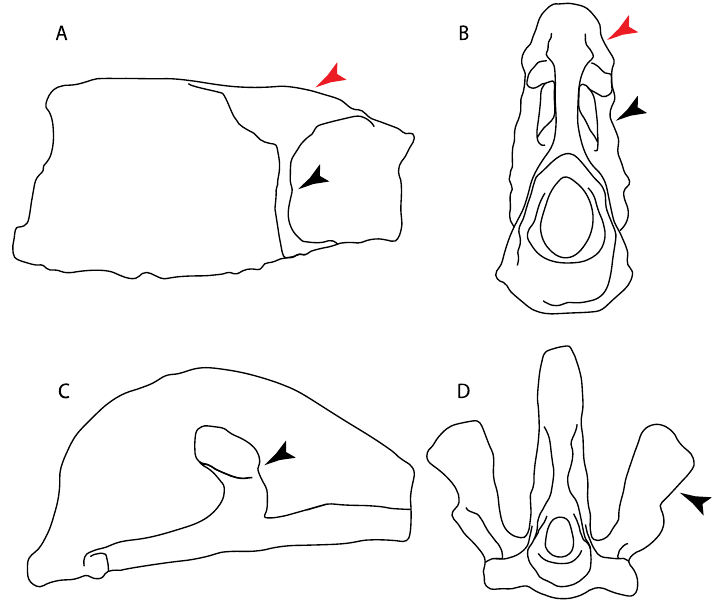
Figure 28. Interpretative drawings of lateral and frontal view of the synarcual. State (0): ( A , B ) Mob- ula munkiana. (SIO 85-34, https://sharksrays.org/ (accessed on13 April 2020)). State (1): ( C , D ) Rhina ancylostoma (LACM 38117-38, https://sharksrays.org/ (accessed on13 April 2020)). Arrowheads: lat- eral stays (black); medial crest